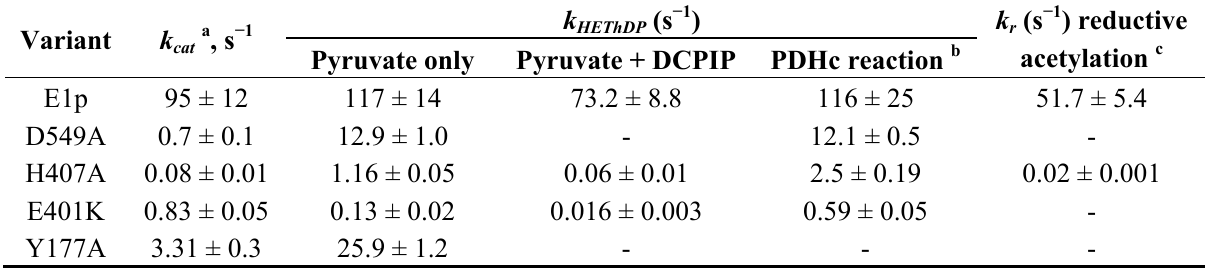
Table 3. Comparison of Pre-Steady–State rate constants for E1p and variants under various conditions